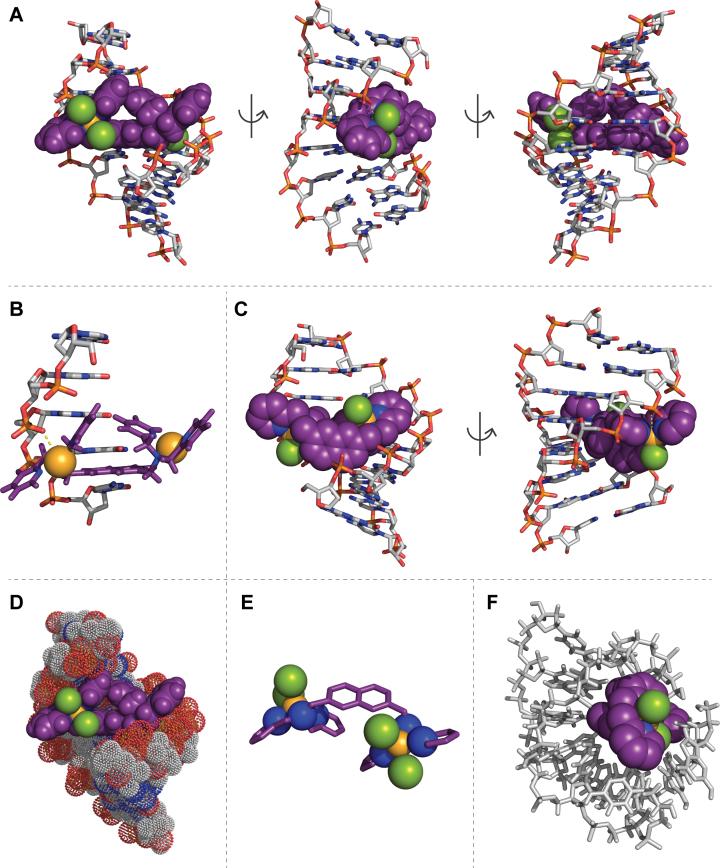
(A) Cu2TPNap docks with d(GGGGCCCC)2 (PDB 2ANA) in the major groove with the naphthalene ring parallel to DNA base pairs; (B) coordination of copper(II) in Cu2TPNap with a phosphate oxygen atom at the second GpG step (chlorides removed for clarity); (C) Cu2TPNap2+ dication docking with d(GGGGCCCC)2 in the major groove where the naphthalene ring orients orthogonal to DNA bases; (D) space filled view of the neutral Cu2TPNap docked with 2ANA (nucleic acid backbone shown as dots); (E) symmetry of the neutral complex when docked with 2ANA; and (F) analysis of the adduct DNA-metal complex using a two-level ONIOM calculation whereby the d(GGGGCCCC)2 sequence relaxes about the di-Cu2+ complex. Figures generated using the PyMOL Molecular Graphics System, Version 2.0 Schrödinger, LLC. Complex colour scheme: copper, lightorange; oxygen, red; carbon, violetpurple; nitrogen, deepblue; chloride, splitpea; hydrogen; white.